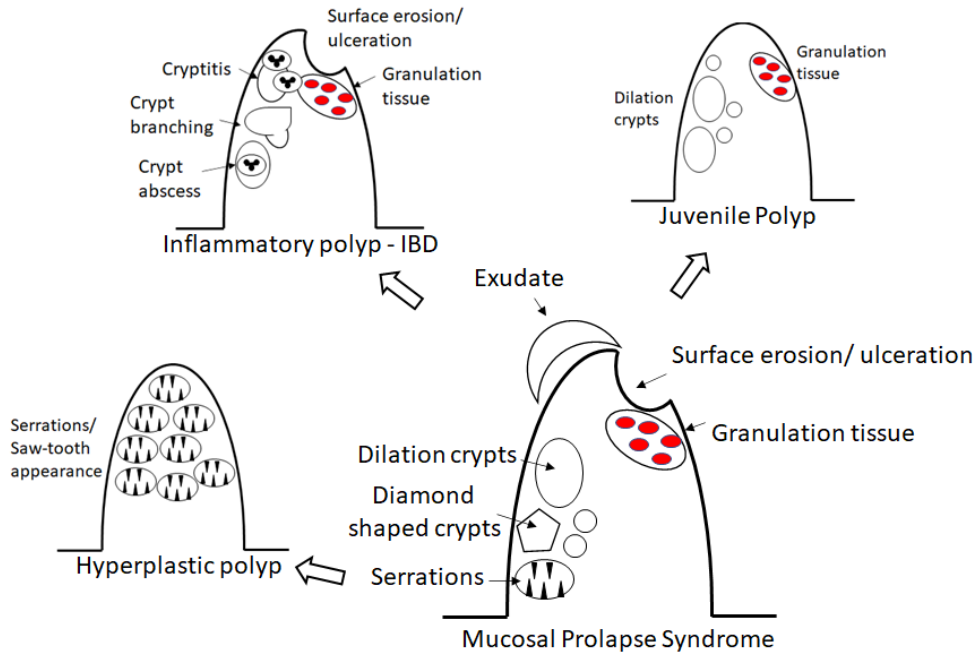
Figure 4. A diagram demonstrating the similarity and differences of mucosal prolapse syndrome with its